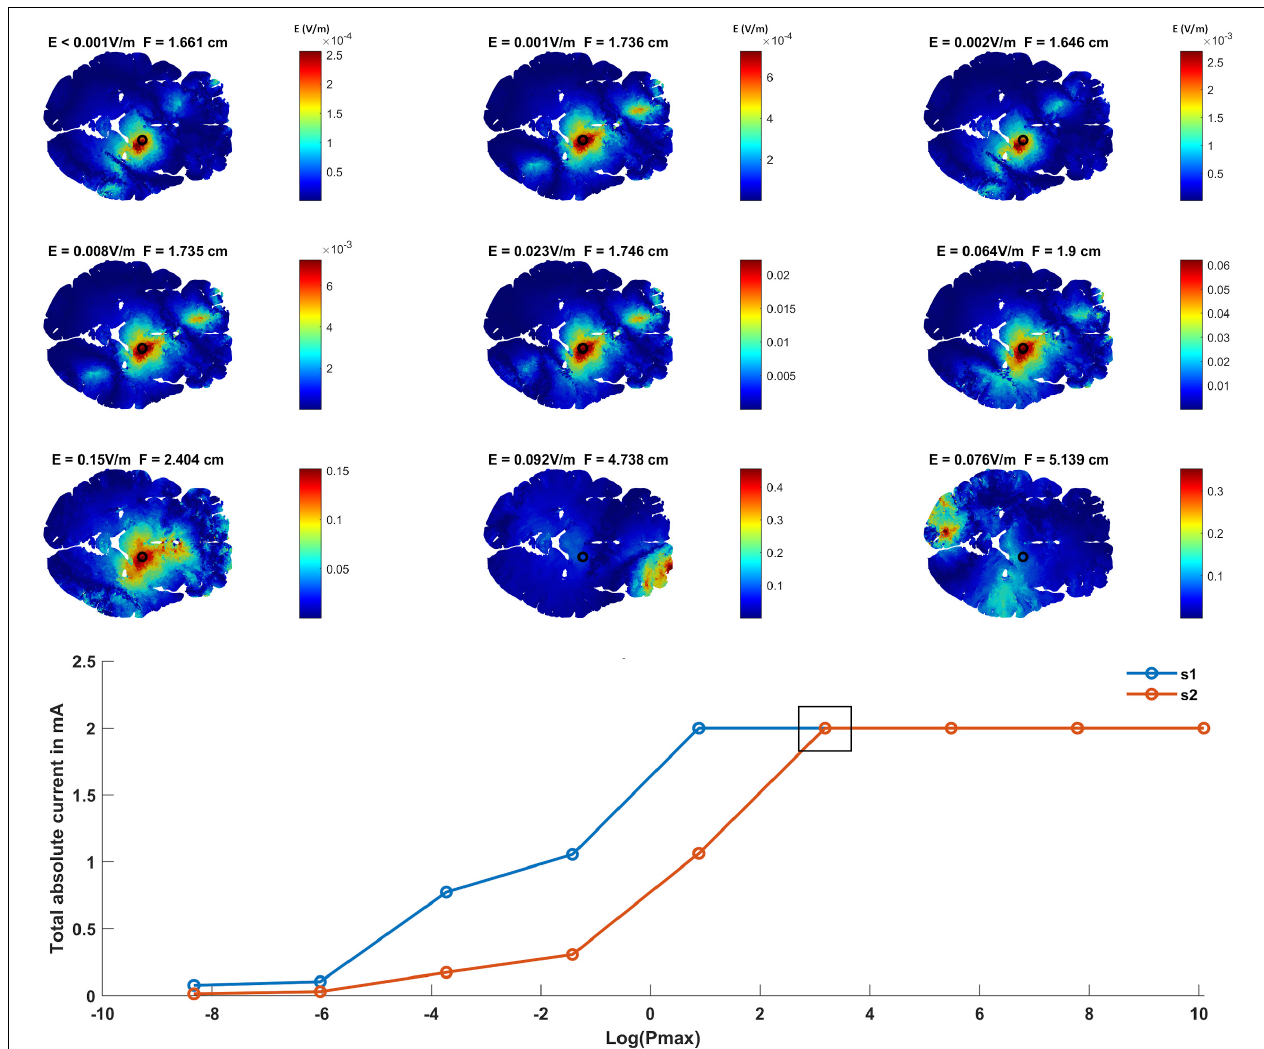
FIGURE 2 | Finding the grand optimal interferential stimulation-epicranial cortical stimulation (IF-ECS) configuration for STN stimulation and studying the effect of increasing the maximum allowed electric field power (P max ) on the induced electric field distribution. The first three rows show the interferential electric field distribution induced by the optimal electrode configuration as a function of increasing P max (left to right and top to bottom). The electric field (E) value at the target (STN indicated by a black circle) and the focality (F) for each P max value is indicated above each panel. As P max increases, more current is allowed to be injected and more electric field is allowed at the non-target regions and the brain in general. However, this comes at the cost of focality with increasing P max leading to a less focused stimulation (higher F values) at the target. The graph at the bottom of the figure shows the total absolute injected current for each of the two sources as a function of P max . As indicated, higher P max values allow more current to be injected. The black box in the graph represents the grand optimal solution. This is defined as the solution for the lowest P max value where the total absolute current of both sources has reached the maximum (1 mA zero to peak). This corresponds to the sixth panel (second row, third column) where E = 0.064 V/m and F = 1.9 cm.